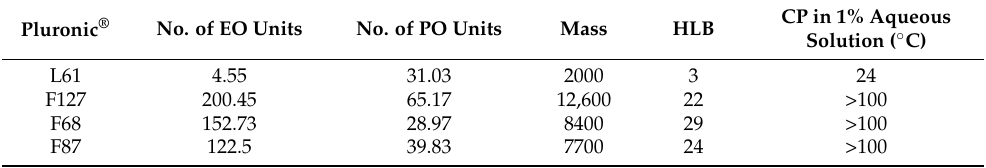
Table 3. Pluronic block copolymers with various chain architecture characteristics.